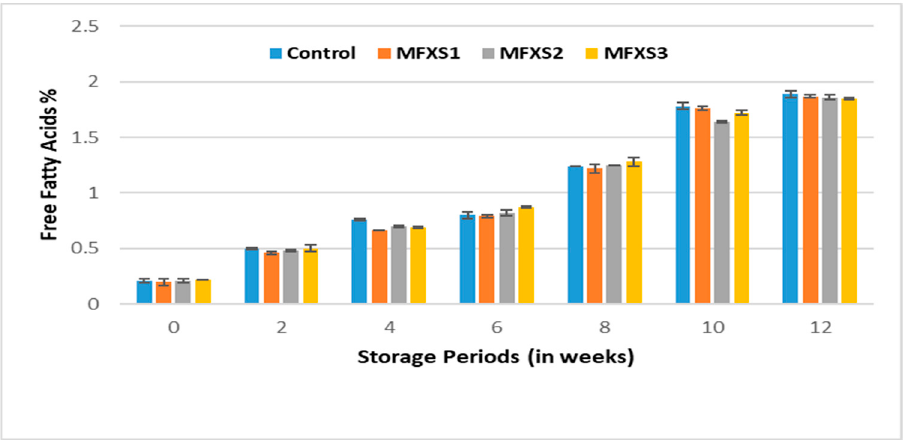
Figure 3. The free fatty acid of mayonnaise samples during ambient storage (25 ± 5 °C). Control and 40% soy bean oil, and MFXS3: 40% flaxseed oil and 30% soy bean oil.